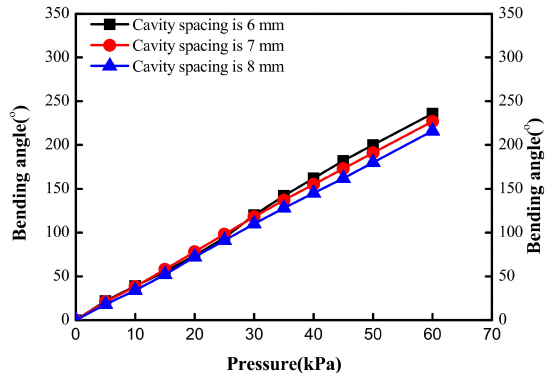
Figure 9. Effect of cavity spacing on bending angle.